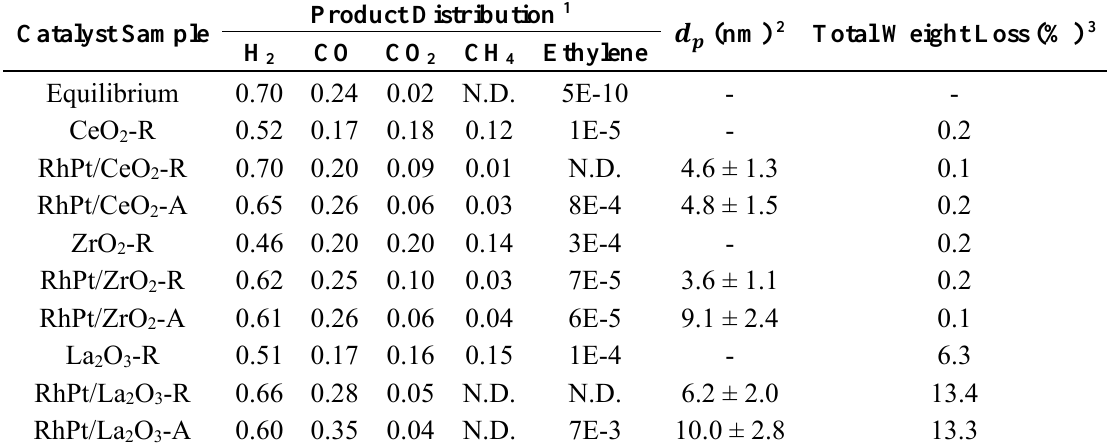
Table 1. Products distribution, catalyst mean active particle size, and carbon deposition in the SRE at 700 °C over reduced (R) and aged (A) RhPt/CeO 2 , RhPt/ZrO 2 , and RhPt/La 2 O 3